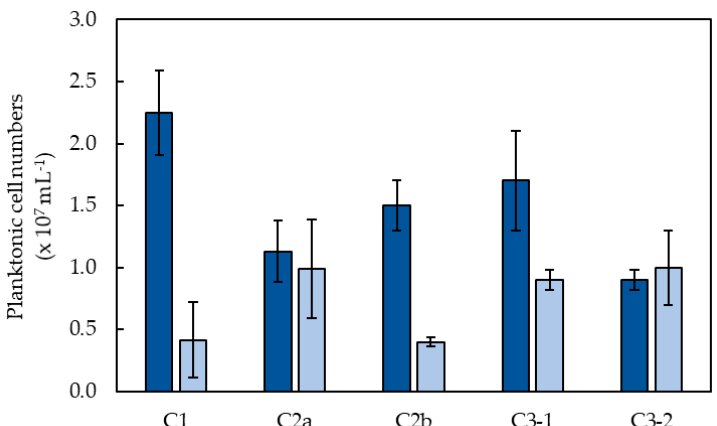
Figure 5. Cell numbers in the feed liquor (dark blue) and effluent liquor (light blue) of the MnOBs. Phases C1 and C2a,b, 1-column system; C3-1 represents column 1 and C3-2 represents column 2 of the in-line 2-column system. The bars depict mean values and the error bars standard deviations (n = 20).